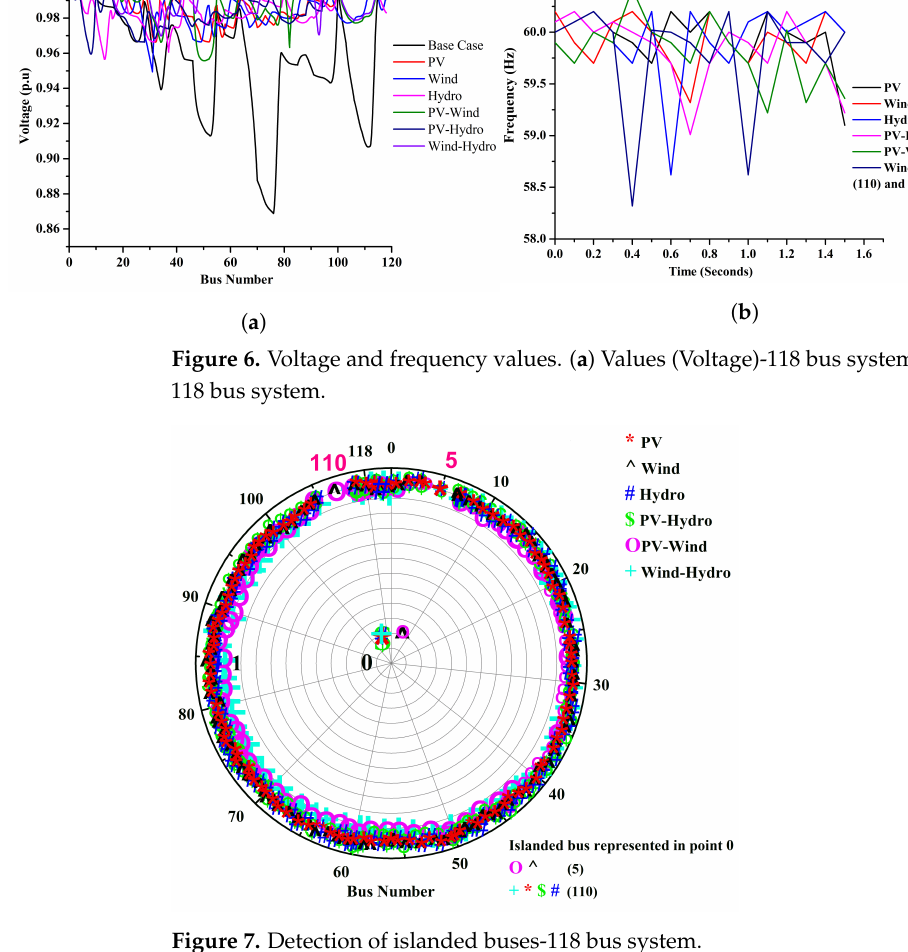
Figure 7. Detection of islanded buses-118 bus